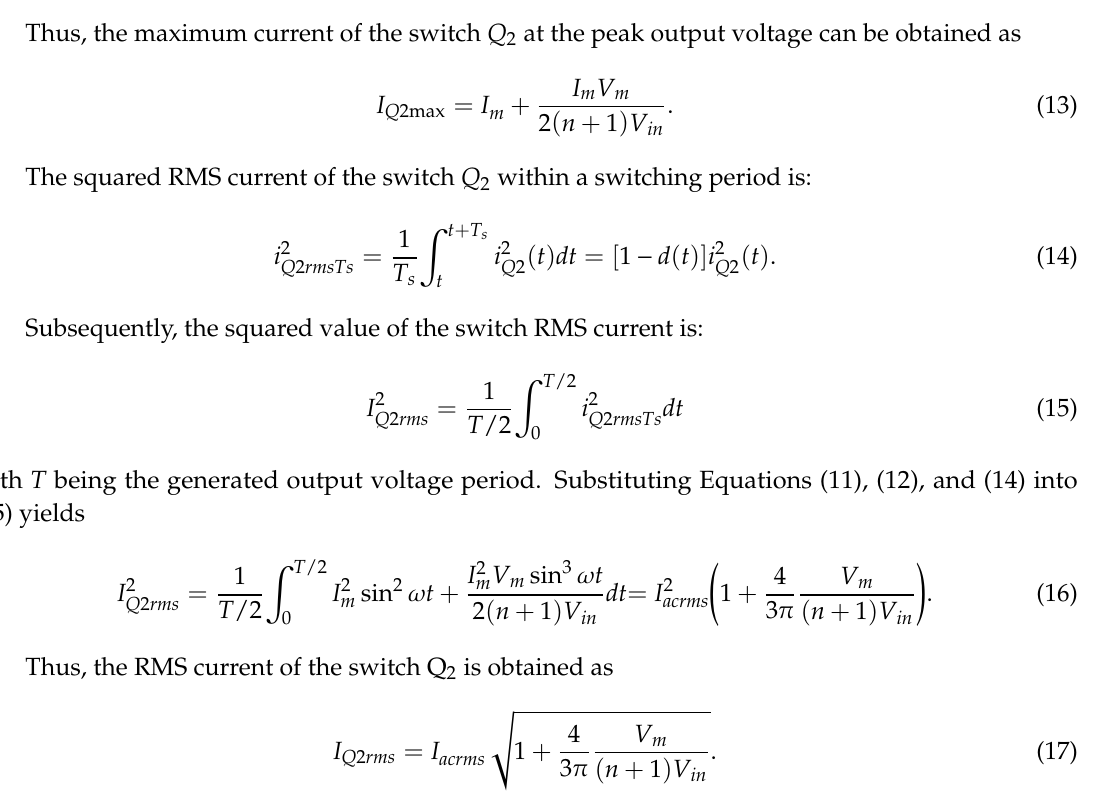
Figure 6. Illustration of the switch current, i Q ( t ), and the average output current, < i o ( t ) > , throughout the half-line cycle.